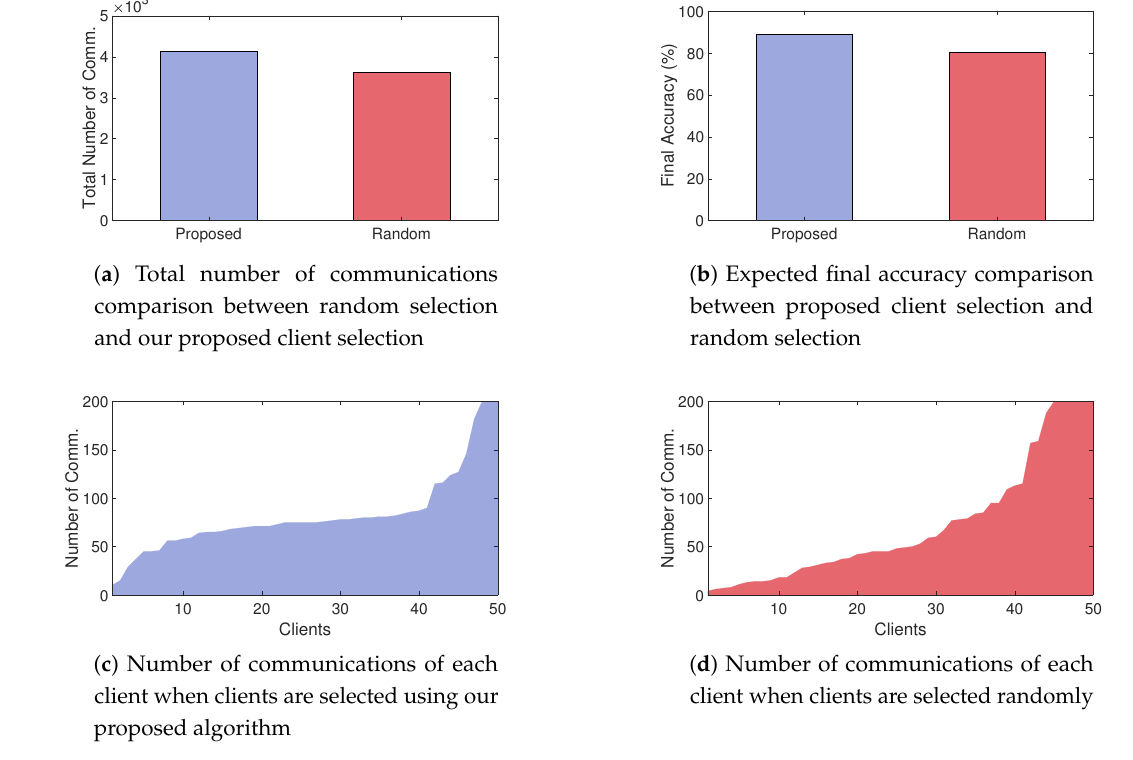
Figure 10. ( a ) Total number of communications between the federated edge and associated clients; ( b ) represents the expected final accuracy based on the learning curve and total number of received data; ( c , d ) represent the number of communications for each client when clients are selected using our proposed algorithm and at random, respectively. ( c , d ) are sorted by number of communications. The variance in the number of communications for each client under our proposed algorithm and random client selection is 41.76 and 62.7,